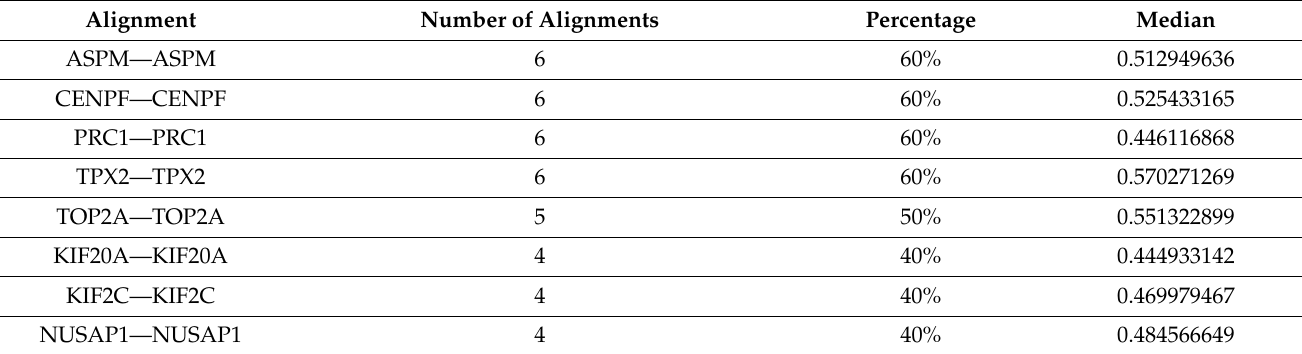
Table 4. Gedevo most common alignments in lung cancer co-expression networks.